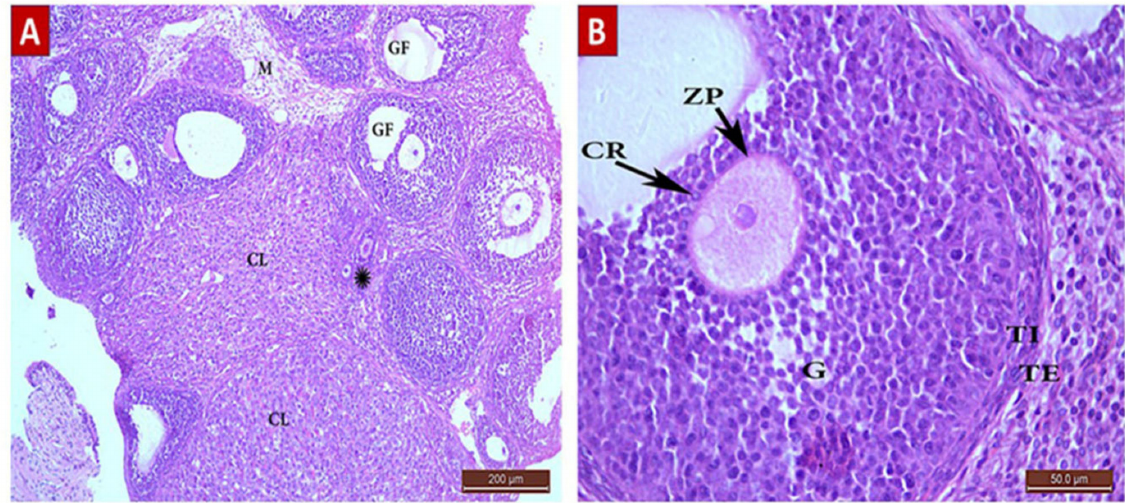
Figure 6. H&E Photomicrograph from G III group showing an improvement in ovarian architecture compared to POI (G II) group. ( A ) Ovarian section from G III group rat at x100 magnification showing little stoma with follicles in different stages of development, primordial and primary follicles (*), multiple Graafian follicles (GF), and corpus lutea (CL) comparable to the control (G I) group. Normal medulla (M) is visible. ( B ) Ovarian section from G III group rat at x400 magnification showing a normal GF with an oocyte surrounded by zona pellucida (ZP), corona radiata (CR), and granulosa (G) cells. The follicle is surrounded by normal layers of theca interna (TI) and theca externa (TE) cells. Diosmin 100 (Group IV, Figure 7) Ovarian sections from the diosmin 100 (G IV) group revealed normal architecture comparable to those from the control (G I) group. There was an increase in the total number of follicles (Table 4) compared to G II and G III. The ovarian cortices had many normal follicles in different stages of